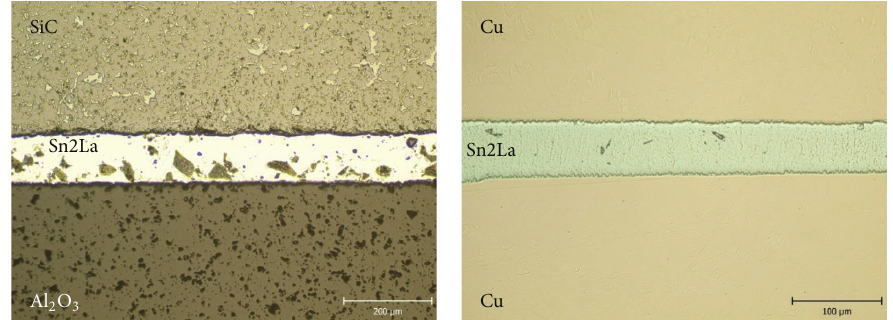
Figure 13: Comparison of microstructure of Sn2La solder after UT soldering at the same parameters and conditions of soldering.